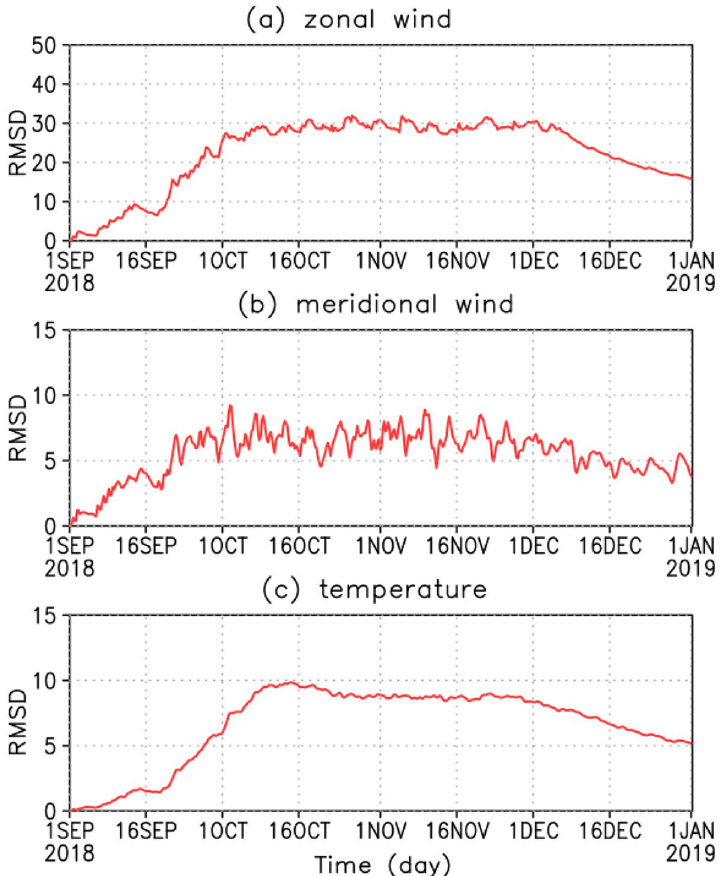
Figure 7. RMSD at 70 km altitude: ( a ) zonal wind, ( b ) meridional wind and ( c )